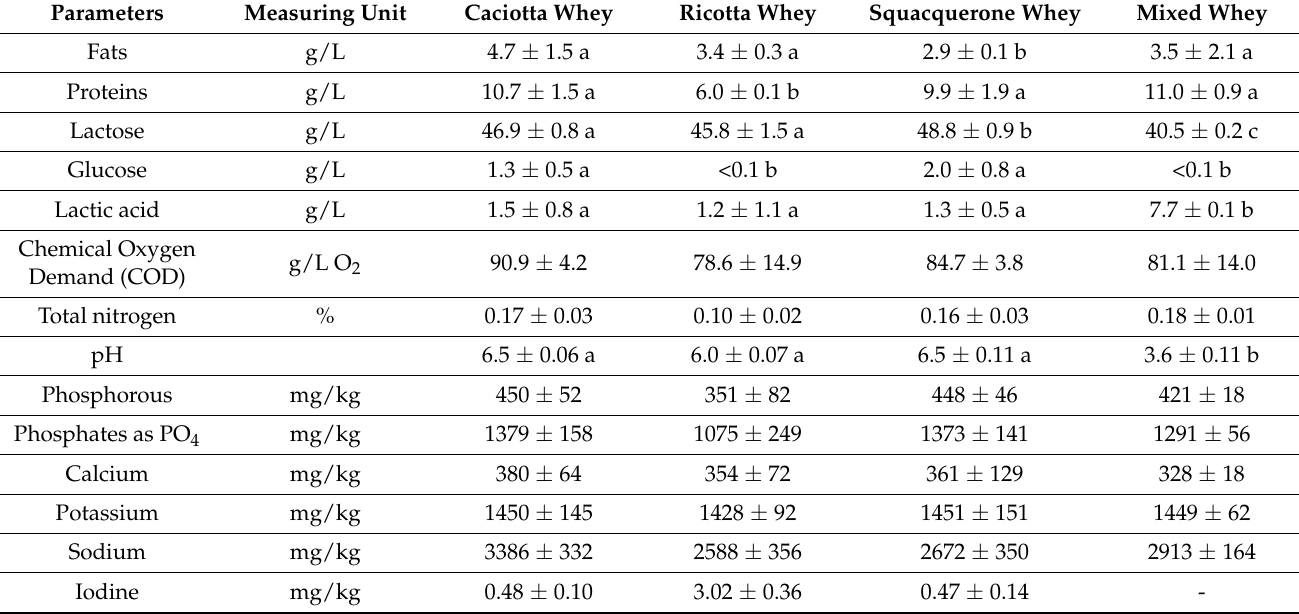
Table 1. Physio-chemical composition of the different cheese wheys used in this study. The data are the mean of three independent measurements. ( n = 3). Different letters among the samples mean significant differences ( p < 0.05).